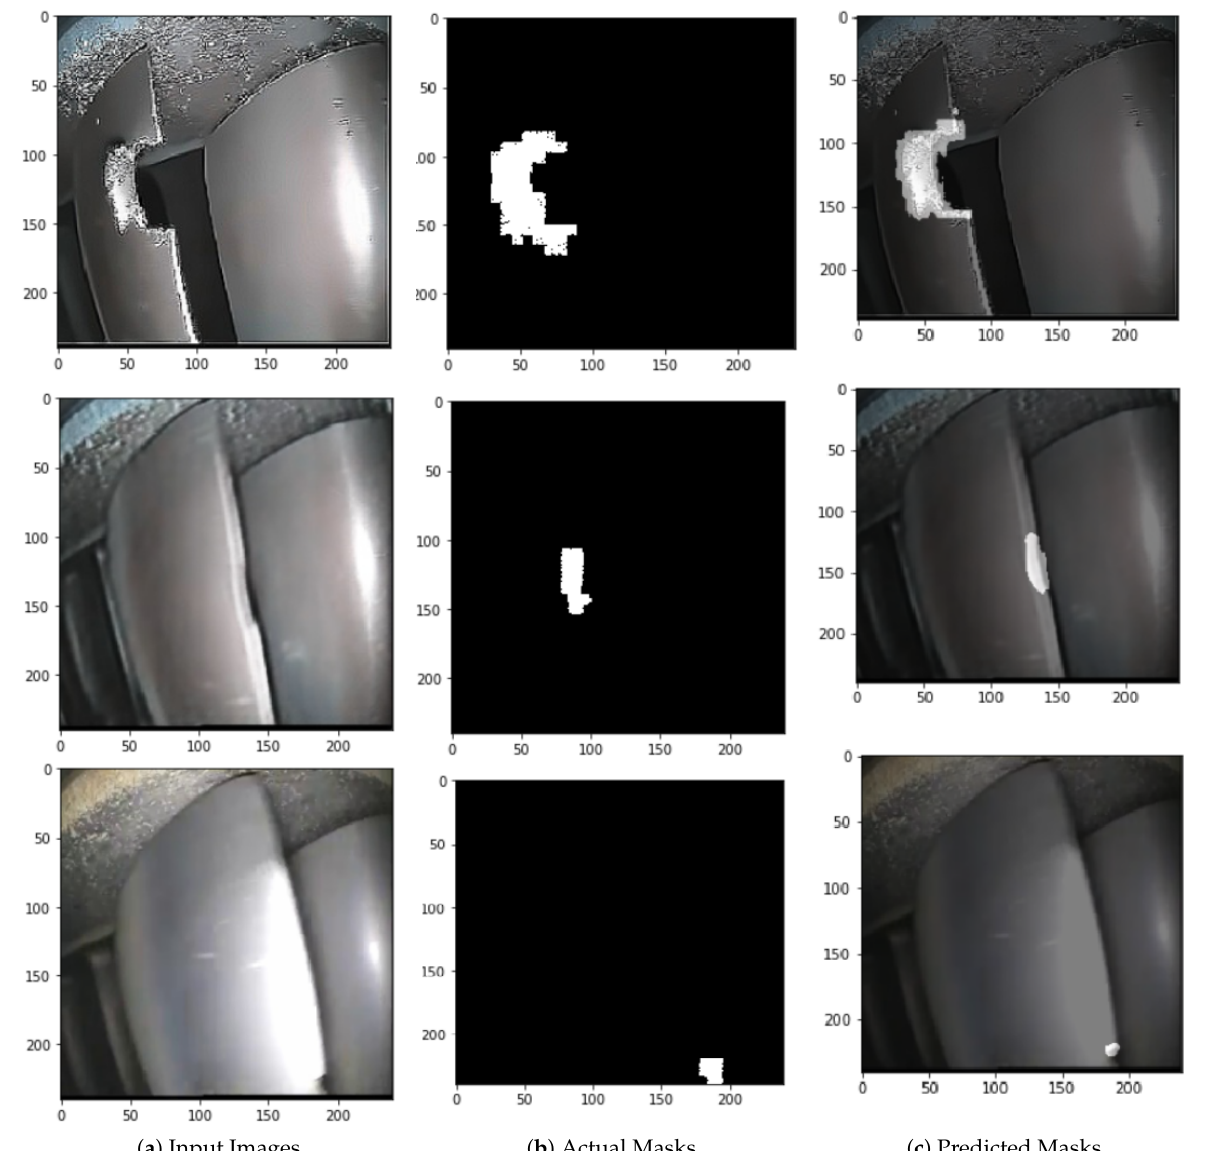
Figure 9. BCE segmentation on test data after 300 epochs.